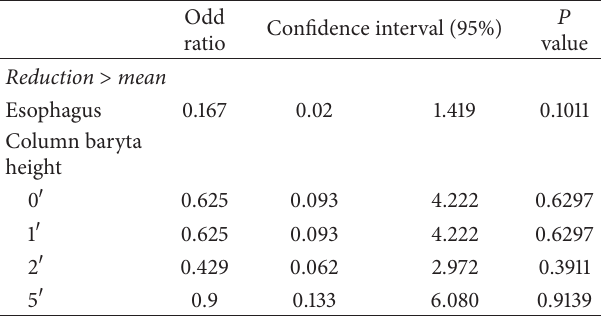
Table 2: Table shows OR, CI 95%, and 𝑃 value calculated with logistic regression model to evaluate statistical significance of the variation between pneumatic dilation and myotomy treatment in patients with diagnosis of